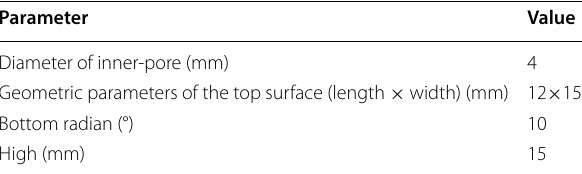
Table 2 Parameters of unit body